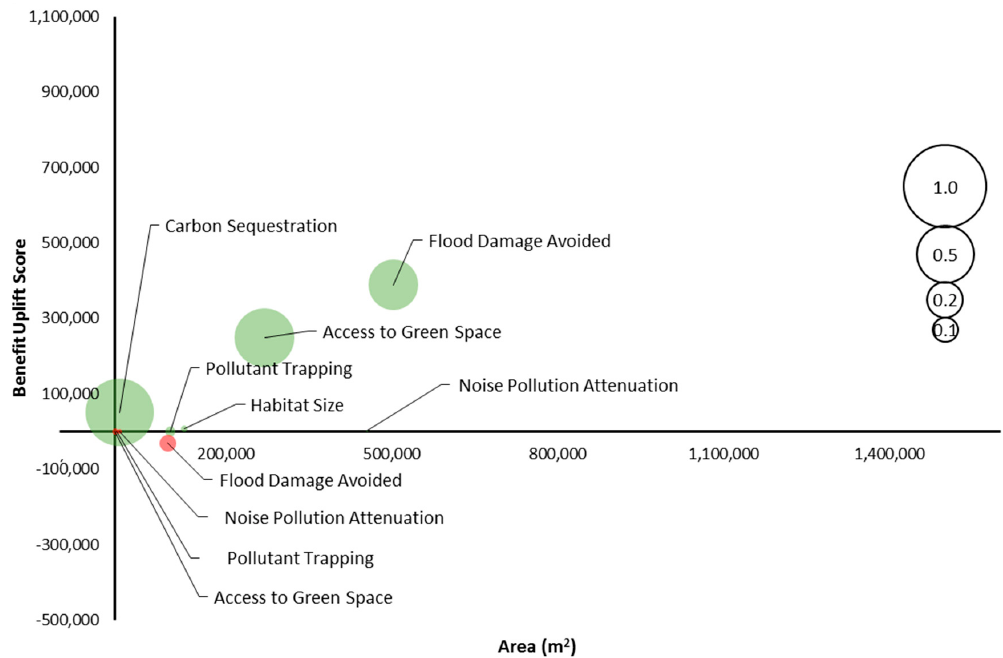
Figure 4. Benefit profile for Newcastle urban core (after Morgan and Fenner [37]).